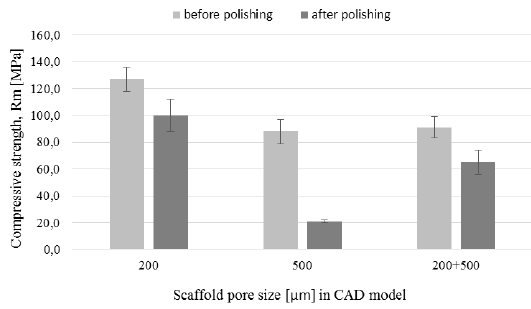
Figure 13. Scaffolds’ compressive strength before and after chemical polishing.